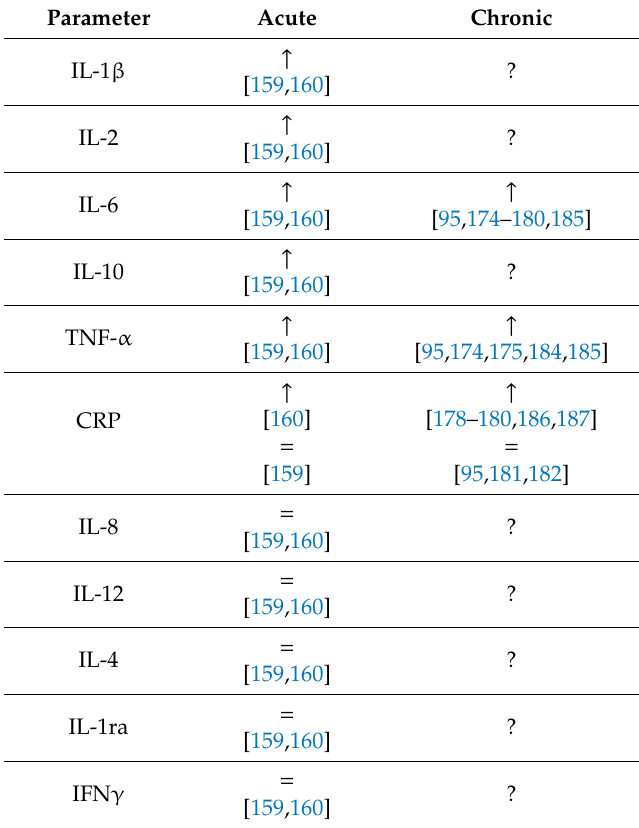
Table 4. Alteration of inflammatory markers factors during acute and chronic